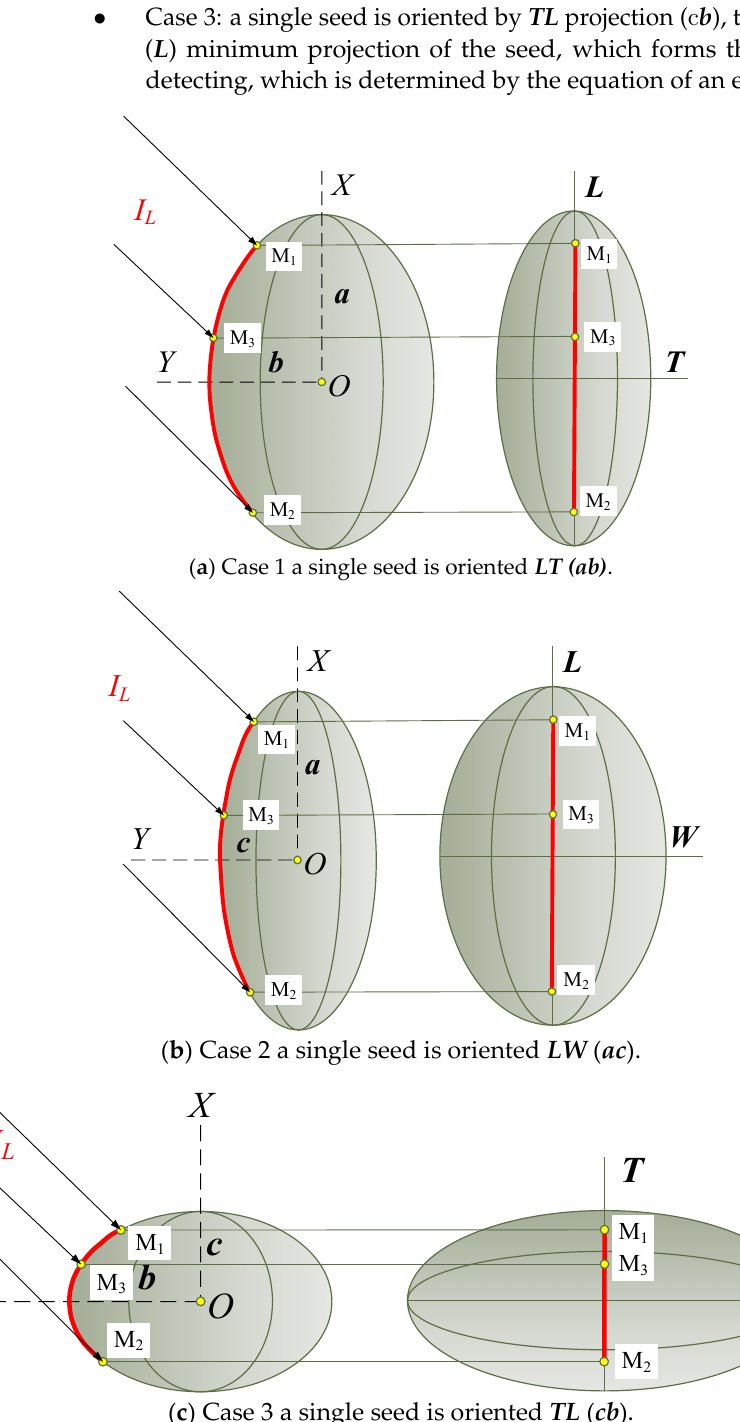
Figure 4. Schemes of orientation of the seed relative to the axis of the optical beam of the incident radiation (recording window 3 on Figure 2). LT ( ab )—first letter sets the side of the seed, parallel to the M 1 M 2 forming a drop beam, defined by the equation of the ellipse with the axes indicated in parentheses, the second letter sets the direction of the seed perpendicular to the first direction in the plane of incidence, in this case, the thickness T; I L is the intensity of the light stream that passes through window 3, illustrated in Figure 2. Here, we are talking about the effective detection surface—the maximum surface of the seed, bounded by the formation of M 1 M 2 , from which the beam emitted by the laser can be reflected continuously. Therefore, we neglect the edge effects (if